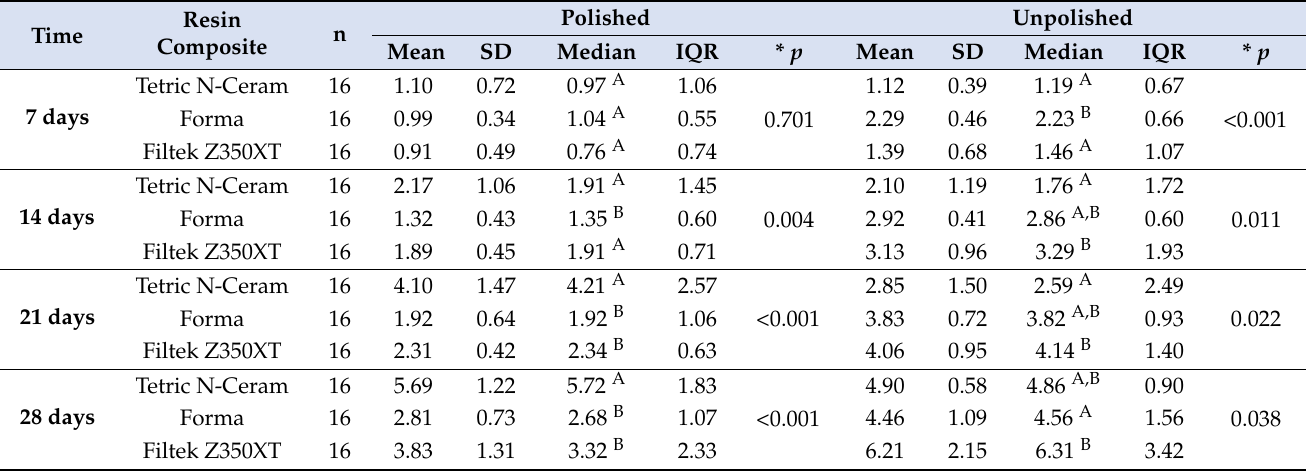
Table 3. Color variation ( ∆ E) comparison between polished and unpolished resin composites accord- ing to time. Polished Unpolished Time